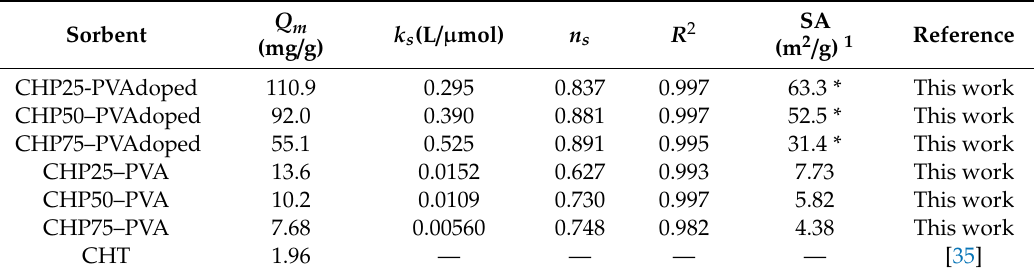
Table 4. Sips isotherm parameters, adsorption capacity ( Q m ) and accessible surface area (SA) for pristine chitosan and ternary composite films in their acid-doped / base-neutralized forms. 1